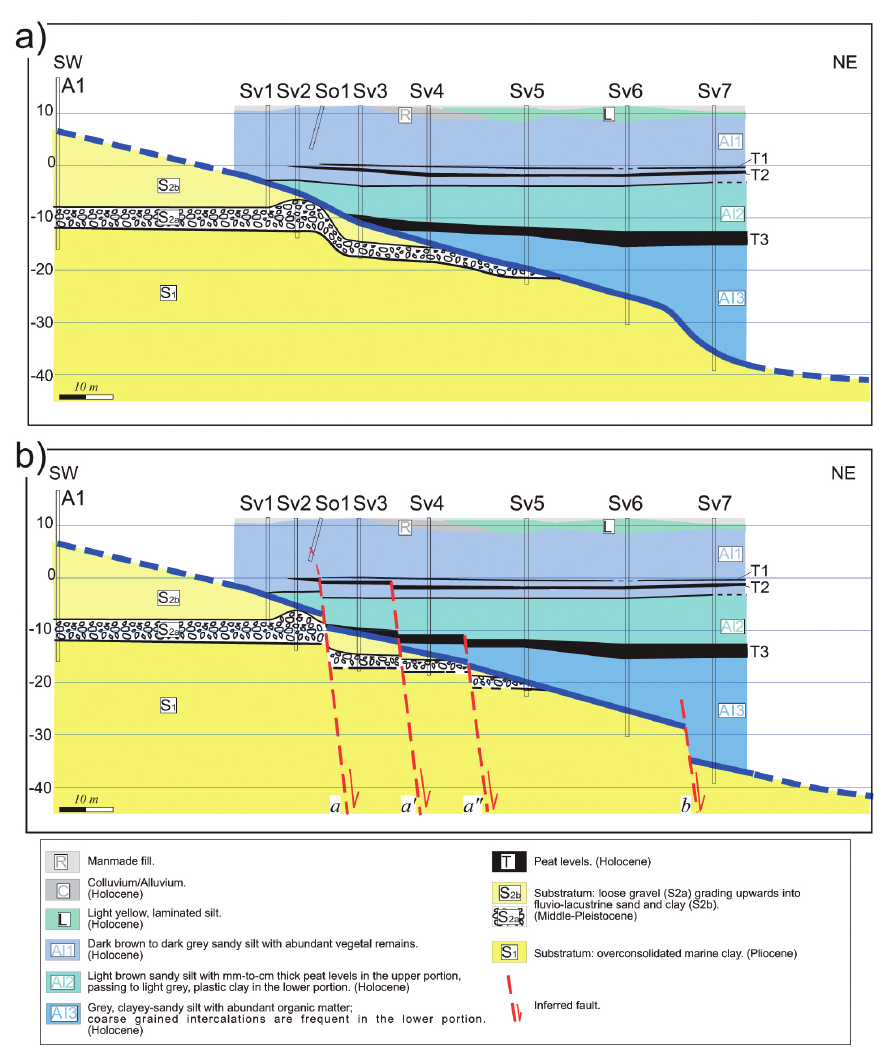
Fig. 5a,b. Detailed stratigraphic cross-section of the southern portion of the Grottaperfetta valley reconstructed by means of boreholes performed for this study (Sv1-Sv7, So1). One acquired stratigraphic log (A1) is also used to constraint the edge of the incision (see fig. 3 for location). a) Uninterpreted profile. b) Interpreted profile: changes in elevation of the stratigraphic limits are associated to fault